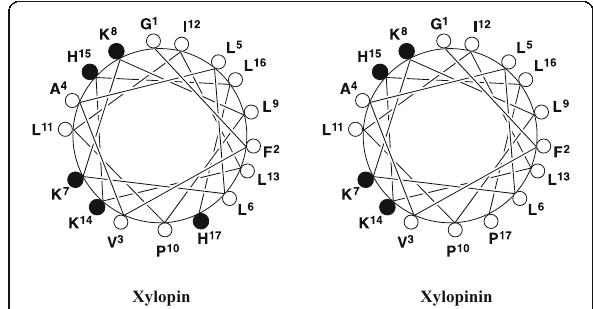
Fig. 3 Helical wheel projection of the sequence of xylopin and xylopinin. In this view through the helix axis, the hydrophilic His (H) and Lys (K) residues are located on one side and the hydrophobic Ala (A), Phe (F), Ile (I) and Leu (L) residues on the other side of the helix